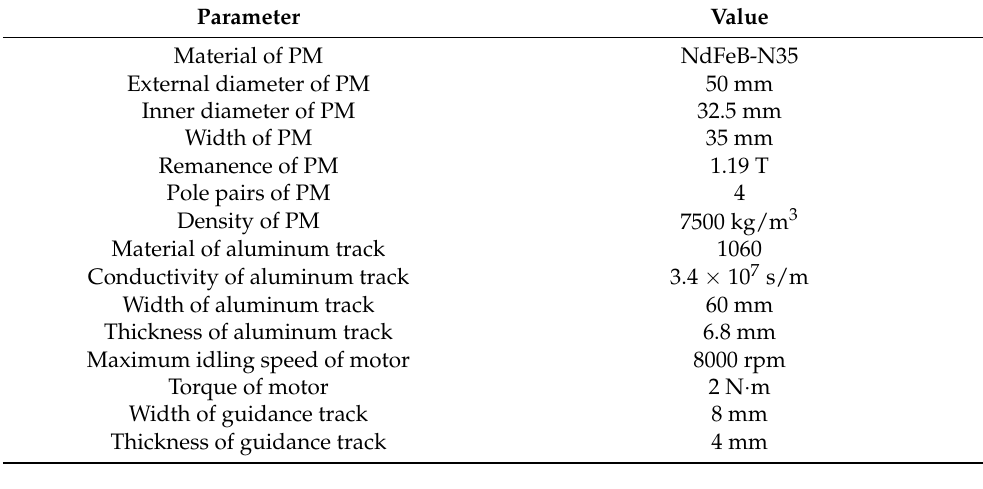
Figure 18. Schematic diagram of the annular PM EDS experimental prototype.